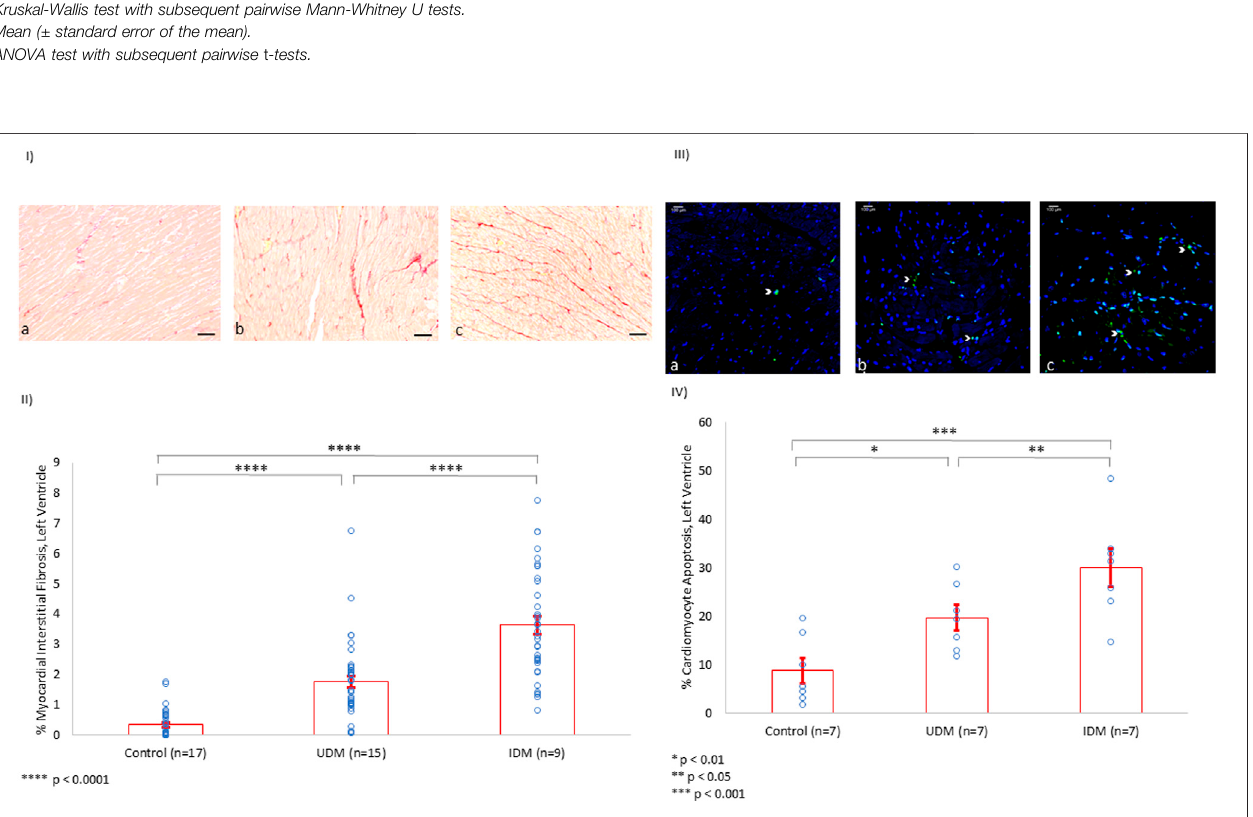
FIGURE 2 | Left Ventricle Myocardial Interstitial Fibrosis and Cardiomyocyte Apoptosis (%). (I) Using Picrosirius red staining of collagen in the extracellular matrix, baselineLV fi brosis among controls(a) wasmeasured (scale bar: 50 µm). UDMand IDM rats experienceda5-fold (b) and 10-fold (c) increaseinLV myocardial interstitial fi brosis,respectively. (II) Quanti fi cationofthemyocardialinterstitial fi brosis. (III) UsingTUNELassay,apoptoticmaterialappearedgreen(whitearrowhead).Comparedto controls (a), the rate of apoptosis doubled in the left ventricle of untreated diabetic rats (b) and tripled among IDM rats (c). (IV) Quanti fi cation of the cardiomyocyte apoptosis in the LV